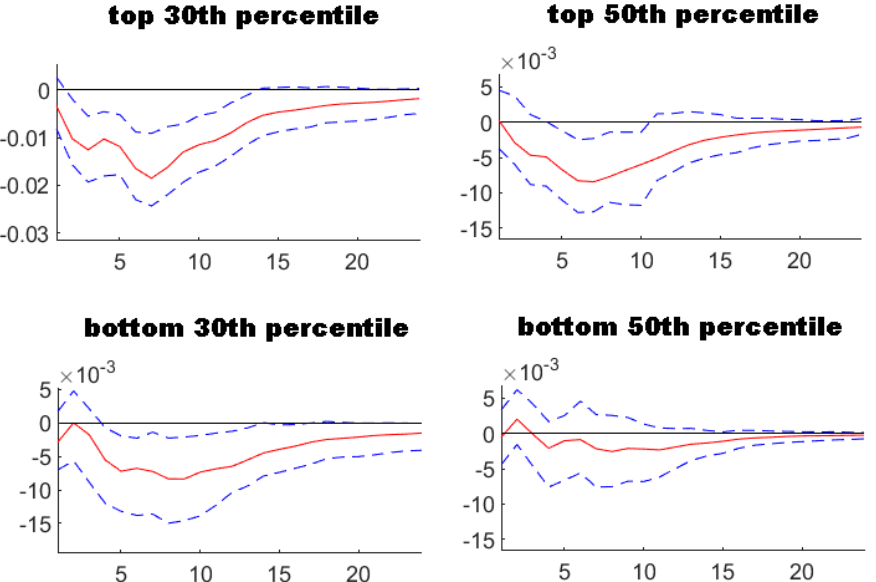
Figure 2. Impulse response functions with an interaction term of different levels of energy import dependency. Notes: the area between the dotted lines represents the 90% confidence interval.